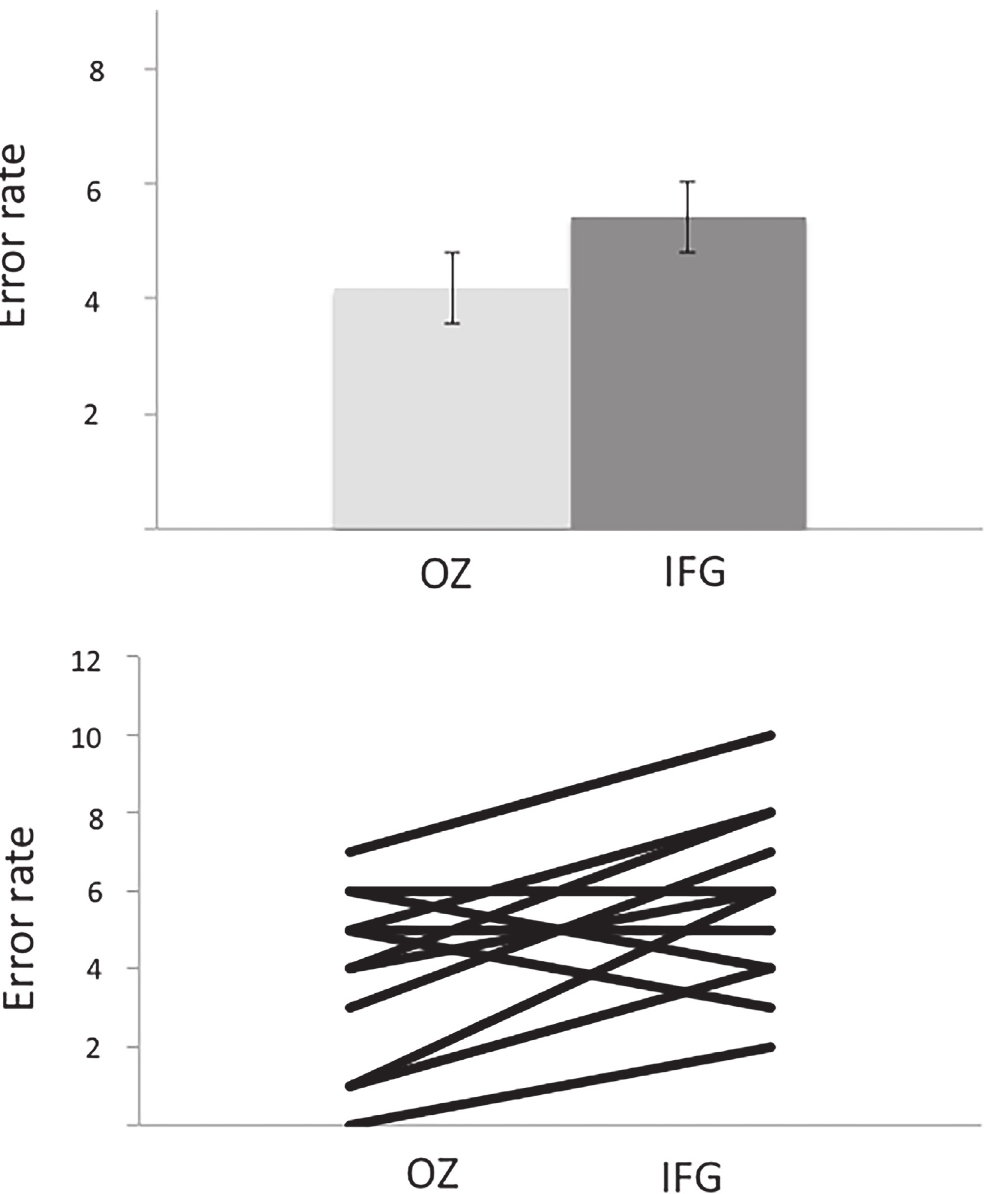
Fig 4. Upper graph: Recognition errors (group mean +/- SE following stimulation of Oz (control site) and IFG (experimental site). Lower graph: Each participant's recognition errors following stimulation of Oz and IFG.